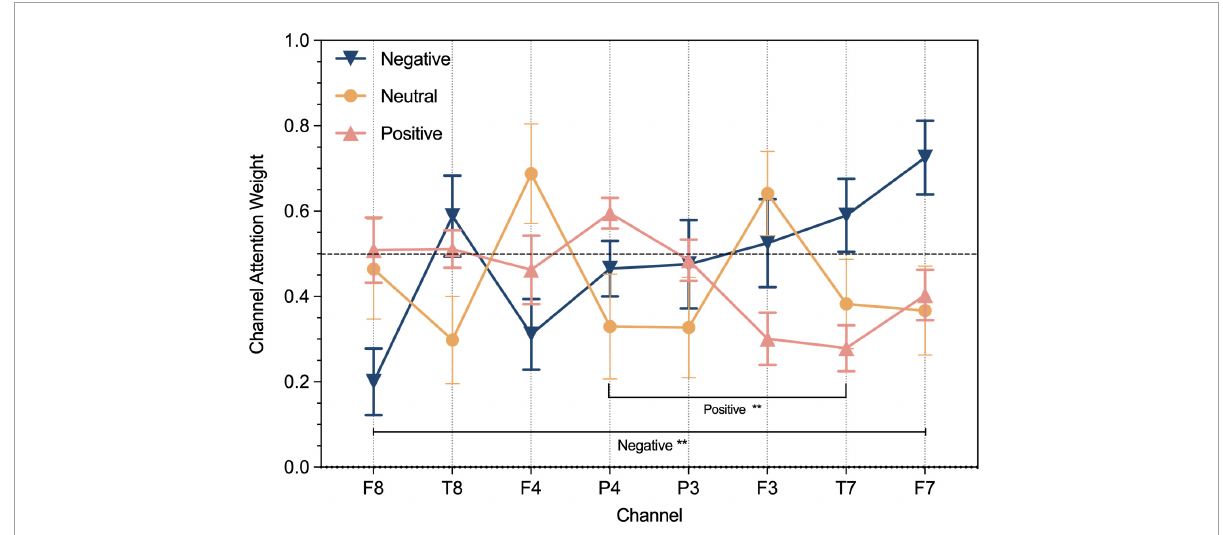
FIGURE4 The result of channel weight on OCER dataset respectively for negative, neutral, and positive emotions. ** P < 0.01.